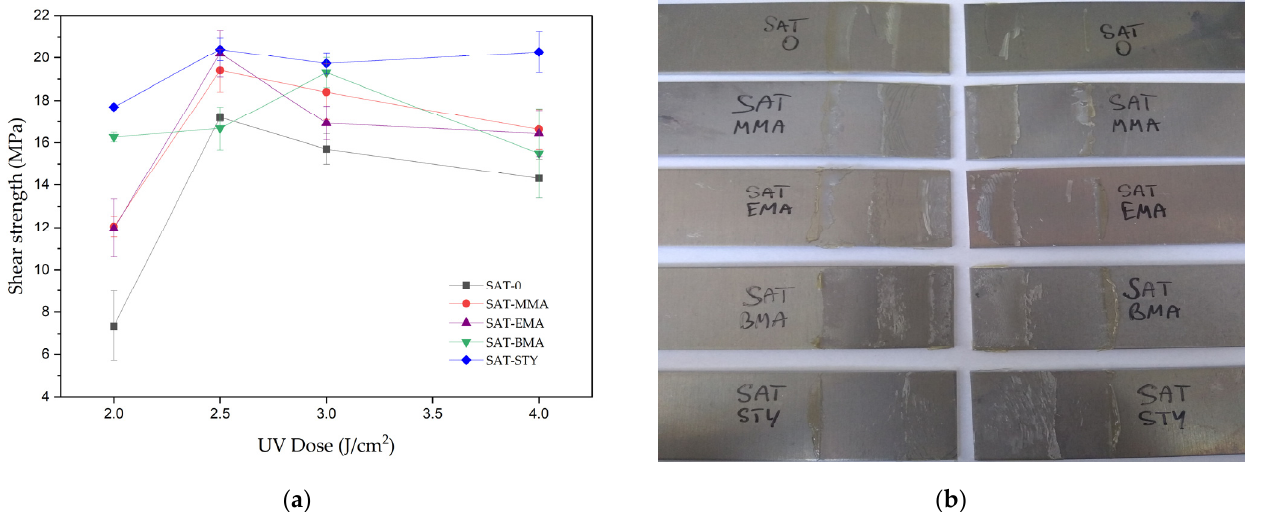
Figure 9. Shear strength of thermally cured aluminum–SAT–aluminum overlap joints ( a ) and view of aluminum panels after shear strength test ( b